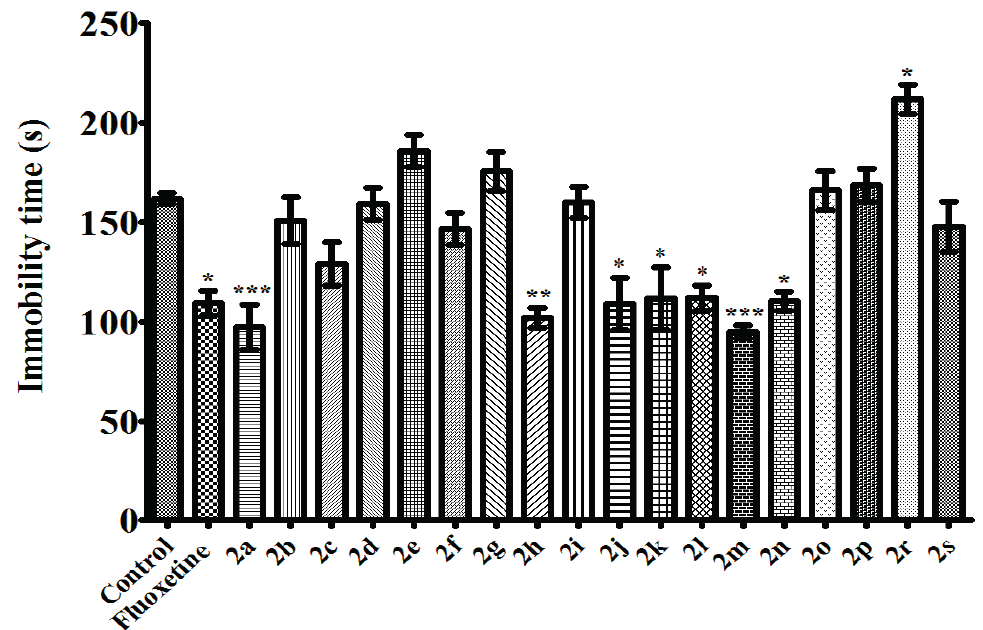
Figure 1. Effects of test compounds (100 mg/kg) and fluoxetine (10 mg/kg) on immobility time of mice in TST. Significance against control values * p < 0.05, ** p < 0.01, *** p <